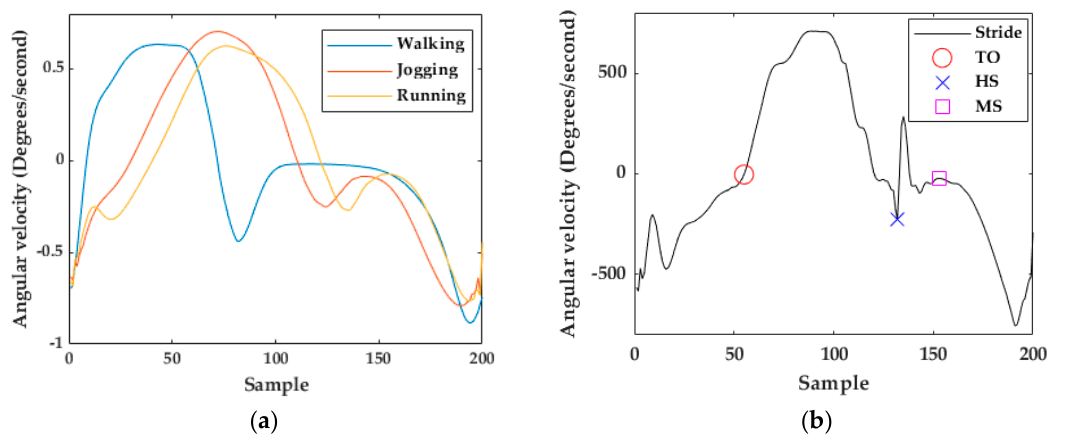
Figure 5. ( a ) Walking, jogging, and running templates (gyroscope z-axis). ( b ) Running stride example (gyroscope z-axis).